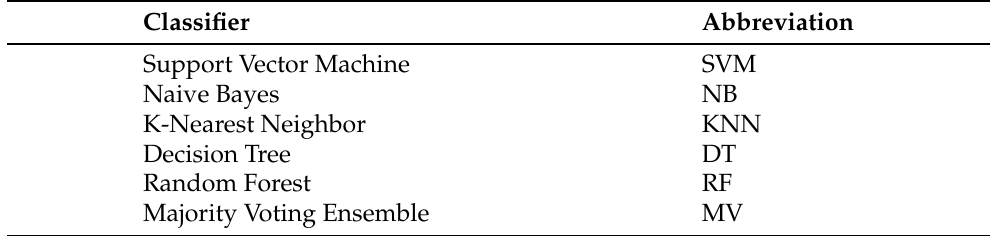
Table 2. Classifiers and their